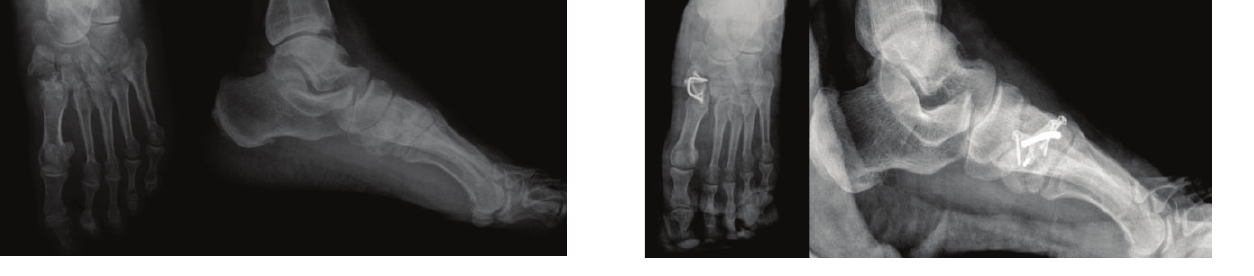
Figure 3: Postoperative anteroposterior and lateral direct